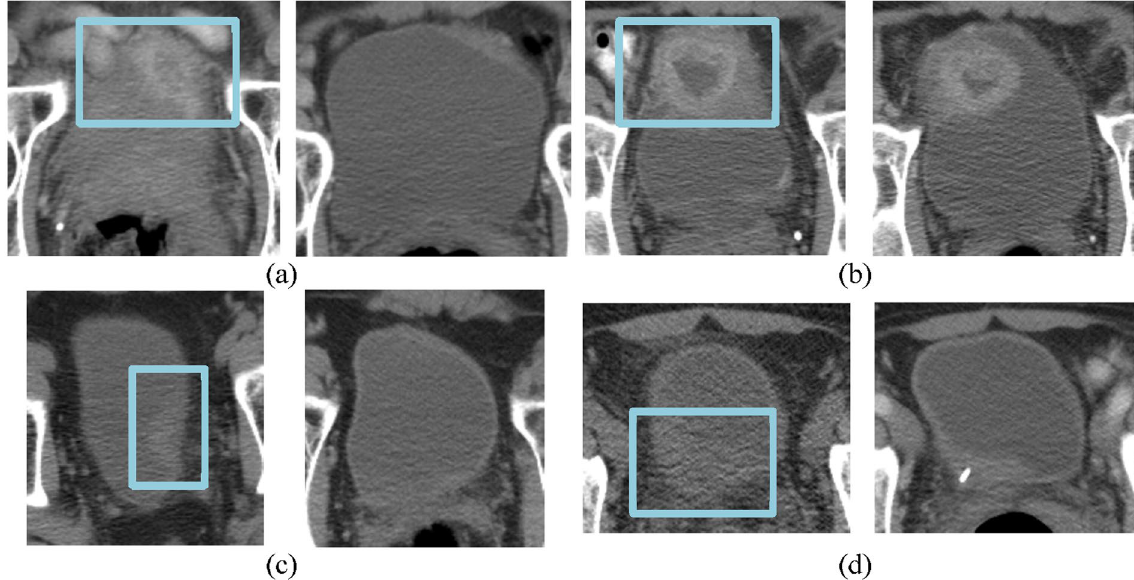
Figure 6. Examples of pre- and post-treatment bladders and their predictions. ( a ) The computer methods and the radiologists correctly predicted the treatment outcome for this case, which was a non-responding, progressive disease that went from stage T2 before treatment to T3a after treatment. ( b ) In this stable disease case (stage T3), the computer methods and the radiologists correctly identified the case as non-responding. ( c ) This case fully responded, going from stage T2 to T0, and the computer methods and the radiologists correctly predicted the treatment response. ( d ) A full-responding case, going from stage T3 to T0. The computers correctly predicted the response, while the radiologists did not. The region around the right ureterovesicular junction was asymmetrically thickened, which might have misled the radiologist to assess that cancer was present. The pre-treatment scan is on the left and the post-treatment scan is located on the right of each pair. The box on the pre-treatment scan represents the location of the lesion as marked by one of the radiologists.